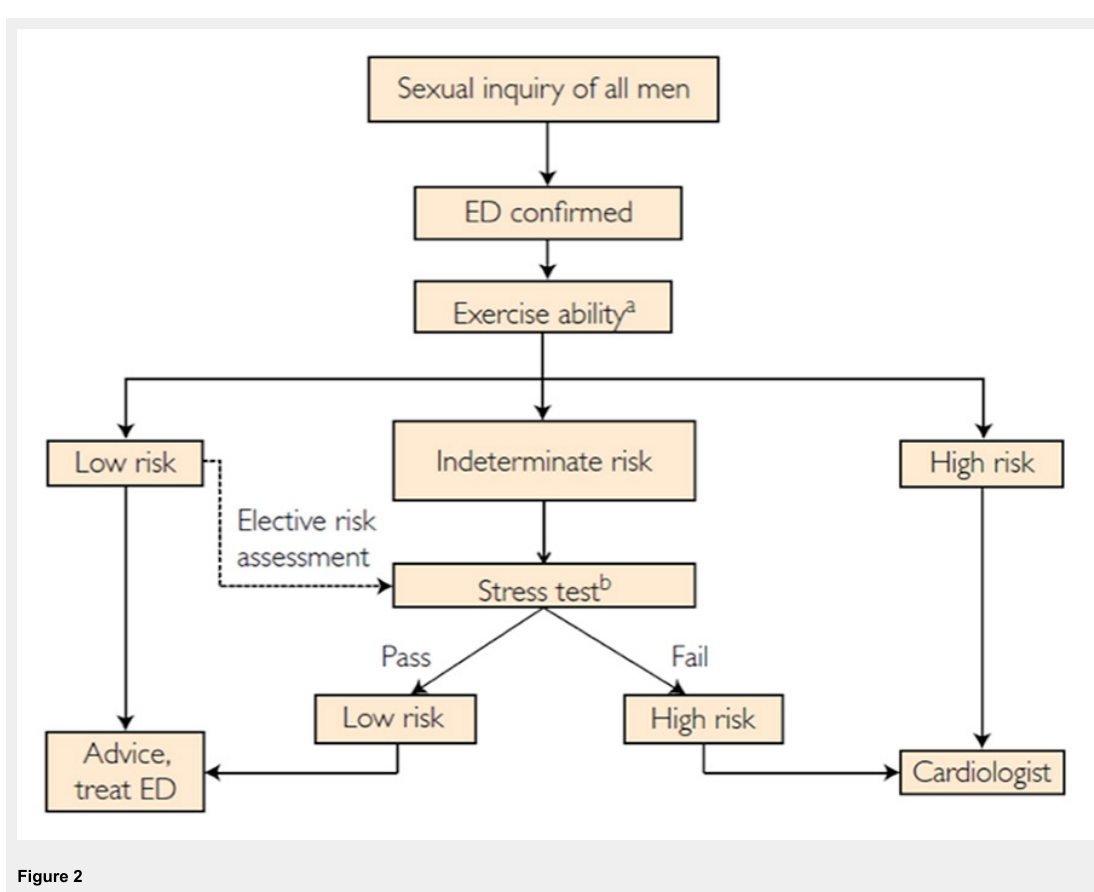
Figure 2 Management of erectile dysfunction (ED) in patients with cardiovascular disease. a Sexual activity is equivalent to walking 1 mile on the flat in 20 min or briskly climbing two flights of stairs in 10 seconds. b Sexual activity is equivalent to 4 minutes of the Bruce treadmill protocol. Adapted from Nehra et al.